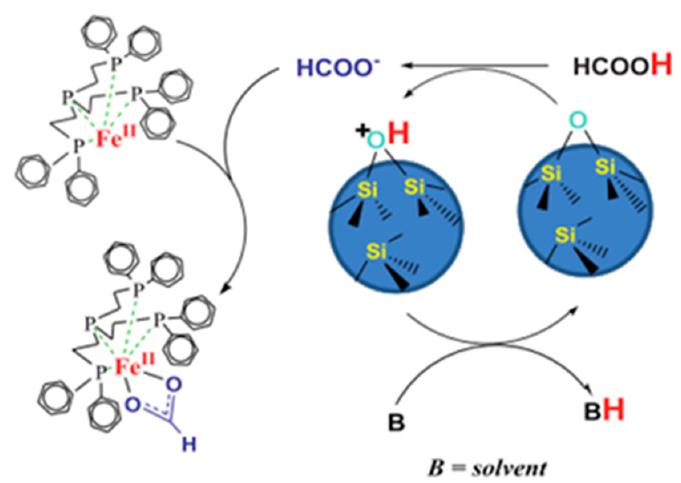
Figure 6. Co-catalytic mechanism of SiO 2 nanoparticles. Figure adapted from Reference [54]. Silica nanoparticles can act as co-catalyst to the Fe/PPh 3 system by promotion of the HCOOH deprotonation.